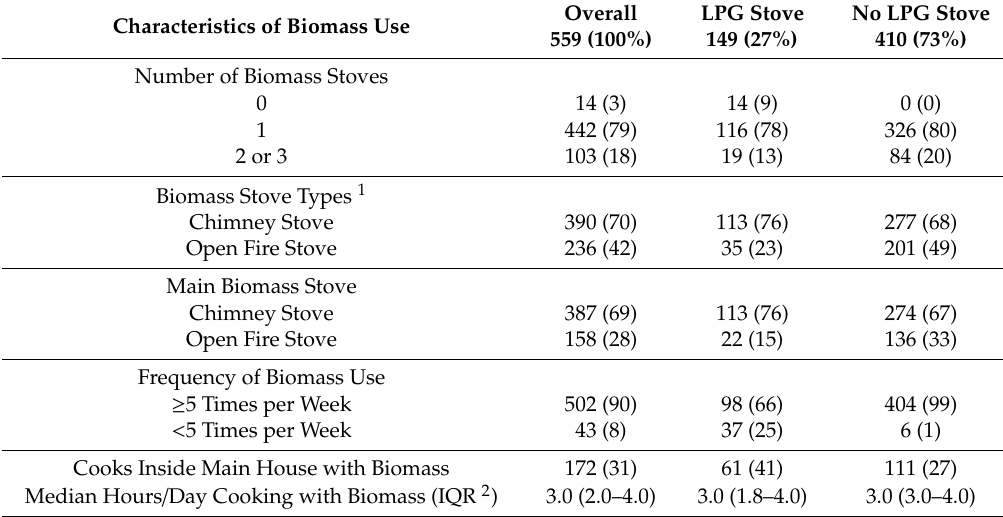
Table 2. Characteristics of biomass stove use among overall personal exposure measures and by liquefied petroleum gas (LPG) stove ownership.